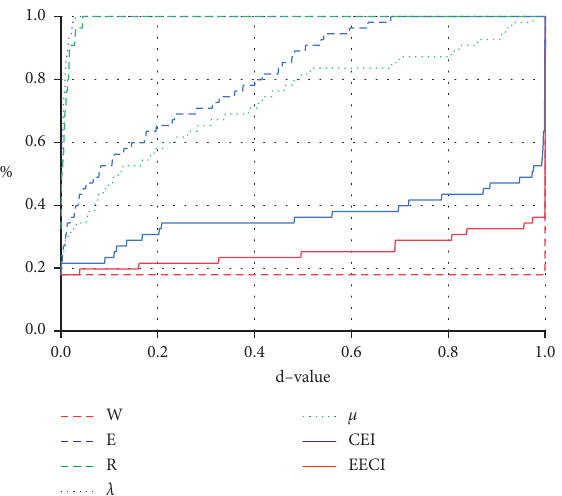
Figure 4: Watts–Strogatz small-world graph with N � 100, k � 4, and p � 0 .